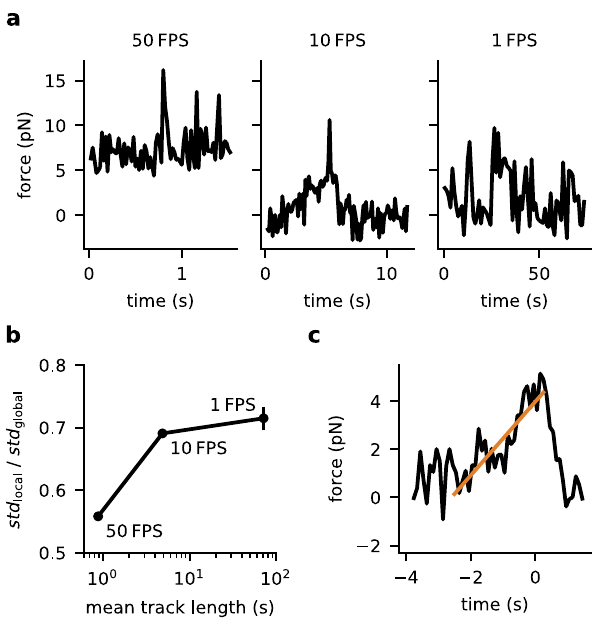
Fig. 4 Temporal analysis of TCR-applied forces observed for activated T-cells confronted with gel-phase SLBs. a Representative single-molecule force traces recorded at indicated frame rates. We observed transitions within force trajectories only in traces recorded at low frame rates, whereas trajectories recorded at high frame rates showed rather constant force levels. b For quantitative readout, we determined the force fl uctuations of each trajectory as standard deviation, calculated the average over all trajectories (termed “ std local ” ) and divided the number by the global standard deviation of all measured force values (termed “ std global ” ) . Ergodic behavior was increasingly observed with decreasing frame rates. Error bars are standard errors of the mean. 4073 events in 94 tracks from 593 movies in dataset (50 fps), 1823 events in 38 tracks from 368 movies in dataset (10 fps), 649 events in 10 tracks from 108 movies in dataset (1 fps). c Assessment of the loading rate for single-molecular force transitions recorded at 10 fps. The panel displays a pooled analysis of 470 data points taken from seven clearly identi fi able single-molecule force ramps, which were synchronized with respect to the force peak. A linear fi t (orange line) yielded an average loading rate of 1.5 pN s − 1 .